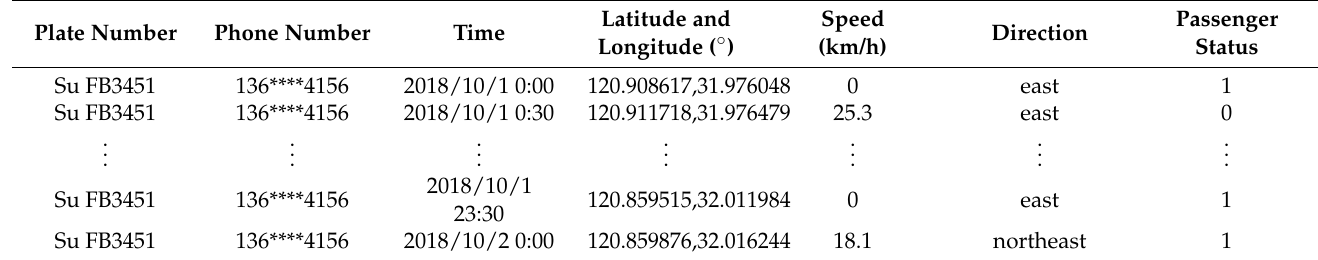
Table 1. Original trajectory